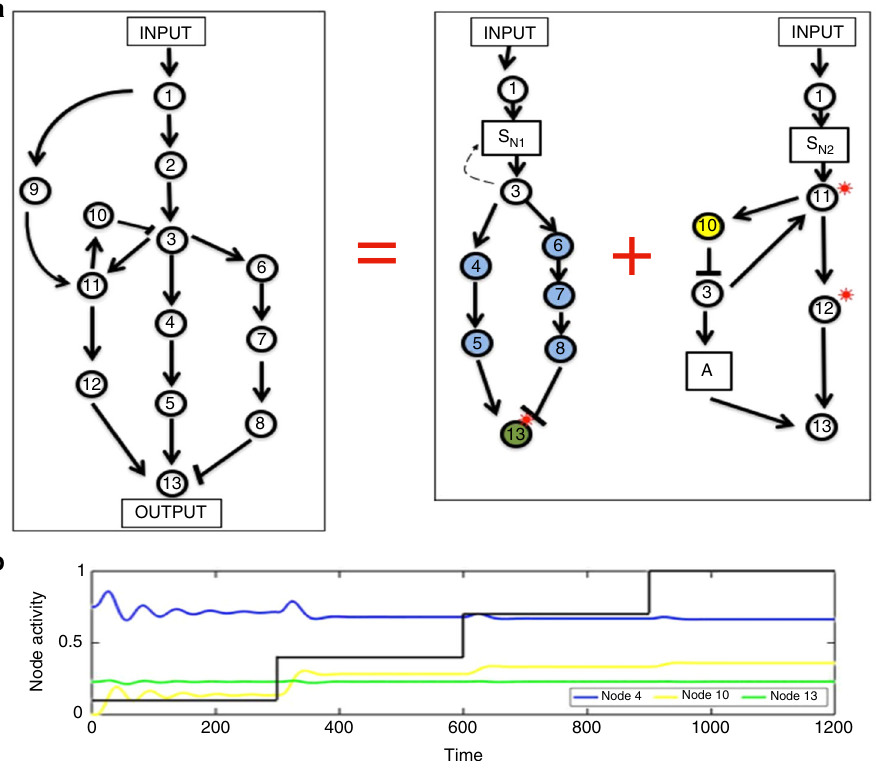
Fig. 6 Opposition and balancing can collaborate in an RPA network. Any network that exhibits RPA must be decomposable into RPA Basis Modules. a Here we provide an illustration of a network topology that is capable of RPA via the decomposition into an Opposer Module (upstream) connected in series with a Balancer Module (downstream). The upstream Opposer Module is created if Node 10 (indicated in yellow) operates with opposer kinetics. Node 10 also participates in a route of the network, corresponding to a live outgoing regulation from the module at Node 3. This live regulation is balanced by the downstream Balancer Module when Nodes 4, 5, 6, 7, and 8 (indicated in blue) operate with balancer kinetics, and Node 13 (in green) operates with connector kinetics. Nodes 11, 12 exhibit the RPA property to the activity of the upstream Opposer Module; Node 13 (the network ’ s output) then exhibits the RPA property due to the combined effects of the two Basis Modules. b Numerical simulations for a simple model of the network in a . Model equations and parameters are given in Supplementary Note 5. The input to the network is indicated in